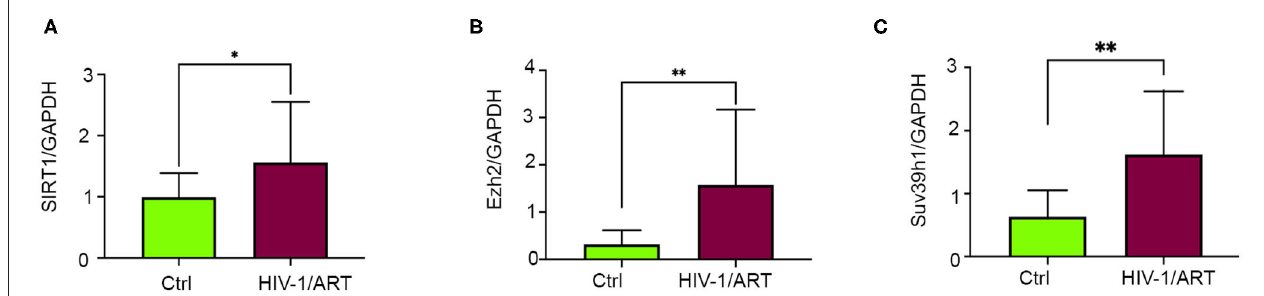
FIGURE 5 | Expression of epigenetic regulating enzymes dysregulated in HIV + patients have history of ART treatment. (A–C) Graphs show expression of SIRT1, SUV39H1, and EZH2 enzymes in human cardiac tissue. Total RNA was isolated from the frozen heart tissue and expression was checked by qRT-PCR (* p < 0.05, ** p <